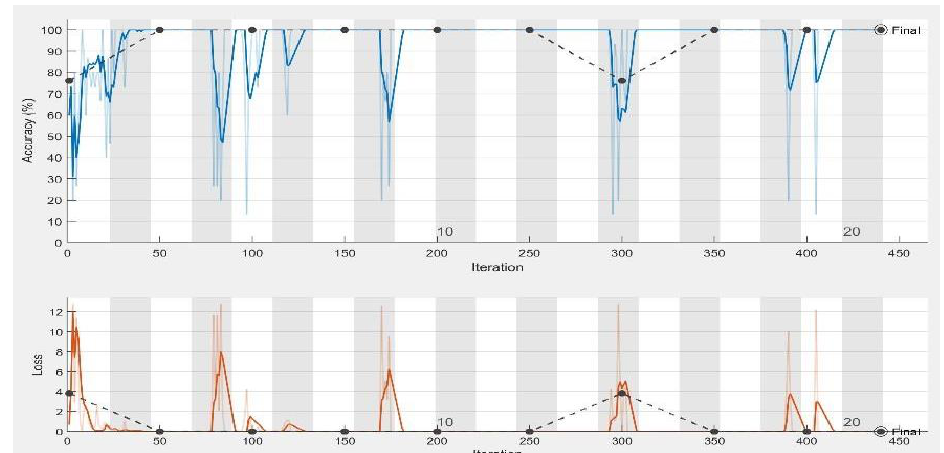
Figure 10. AlexNet training process with a learning rate of 0.001. The figure shows the epoch number, training accuracy (blue line), validation accuracy (black line), and loss function value for the training data (red line) and validation data (black line).